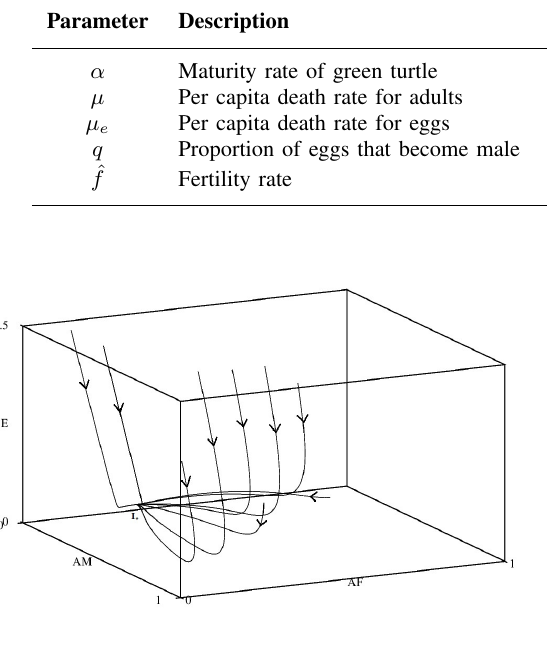
Fig. 5. Solutions of system (4) with ˆ f = 0 . 25 and K = 1